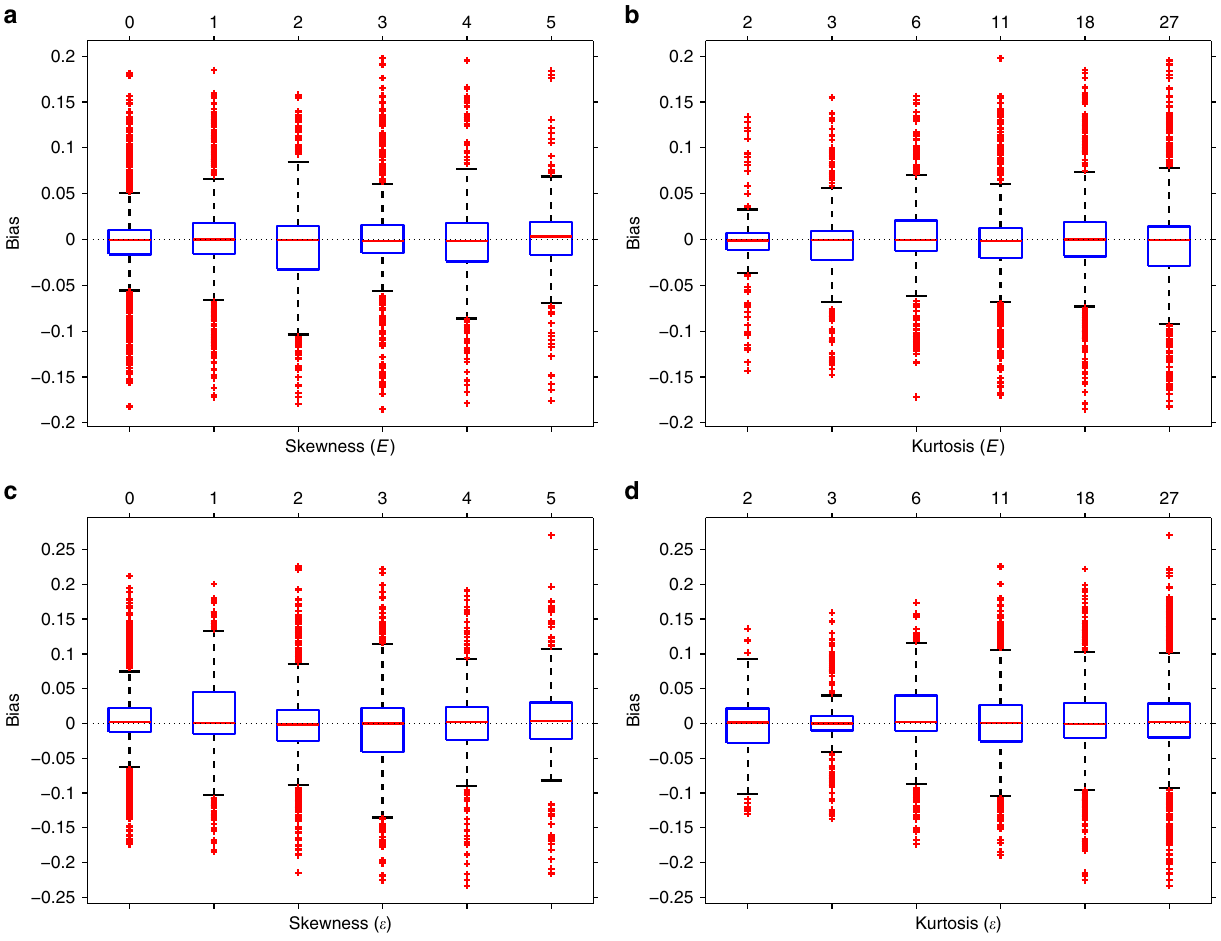
Fig. 2 Interaction effect estimation bias as a function of skewness and kurtosis. Panels ( a , b ): skewness/kurtosis of the environmental variable ( E ), panels ( c , d ) for the noise ( ϵ ). For a fi xed skewness, we pooled the estimates for all possible (tested) kurtosis values and vice versa. Parameters were fi xed as n = 10,000, α 2 0 : 1, α 2 = 0, β 2 = 0.3, γ 2 = 0. Boxplots are based on 500 simulated data sets. Boxes mark the fi rst ( q 1 ) second ( q 2 ) and third quartiles 1 ¼ ( q 3 ), and the lower/upper whiskers are at q 1 − 1.5 ⋅ ( q 3 − q 1 ), q 3 + 1.5 ⋅ ( q 3 − q 1 ), (Supplementary Fig. 5). The results are qualitatively identical for simulation settings when γ = 0 was replaced with γ 2 = 0.025 (see Supplementary Fig. 6). Note that the root-mean-square error (RMSE) and power change with skewness and kurtosis of both the environment (Supplementary Fig. 7) and noise (Supplemen- tary Fig. 8).